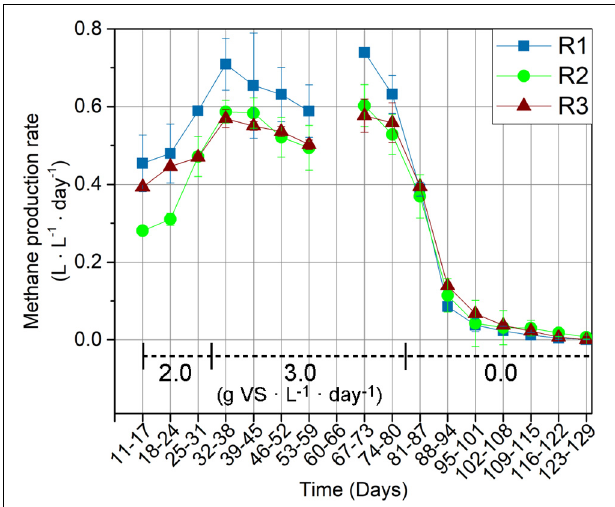
FIGURE 1 | Methane production rates for the thermophilic reactor (R1), and mesophilic reactors (R2 and R3). MPRs are presented as weekly average. The reactors were fed with wheat straw from day 11–81 and organic loading rates (g VS · L − 1 · day − 1 ) are indicated on the graph. The MPR was not recorded during days 60–66 due to a technical error.